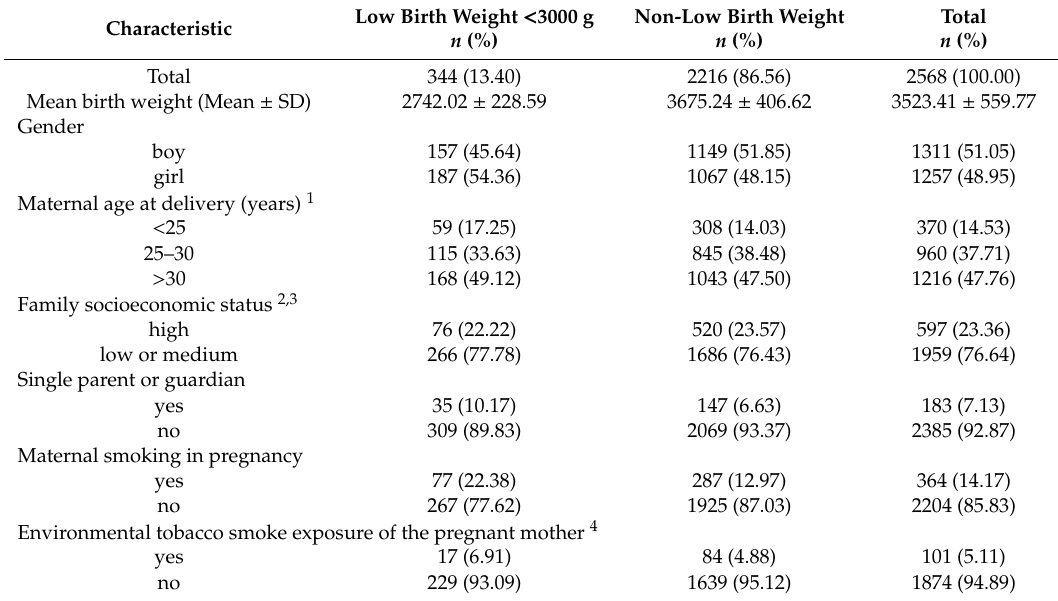
Table 1. Characteristics of the study population, The Espoo Cohort Study, 1984–1990.